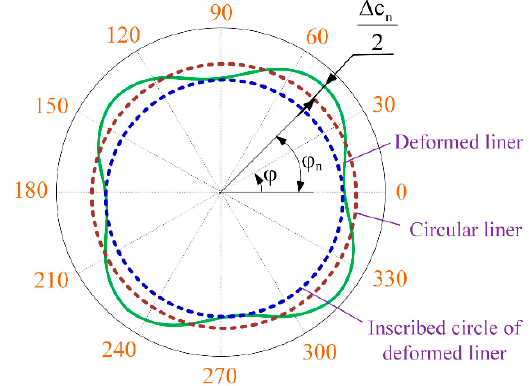
Figure 2. Schematic diagram of the deformed liner for any cross section in the axial direction.